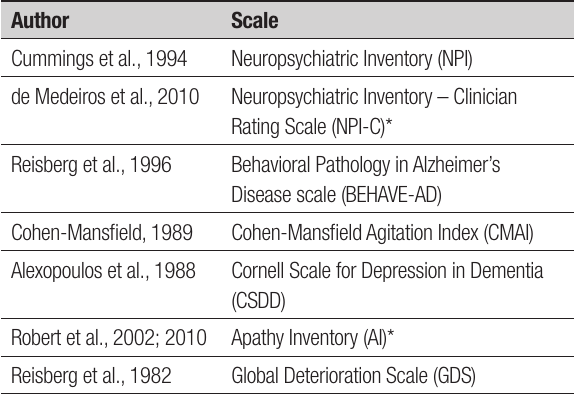
Table 1. Available scales for use in Brazilian settings for assessing neuro- psychiatric symptoms in dementia.